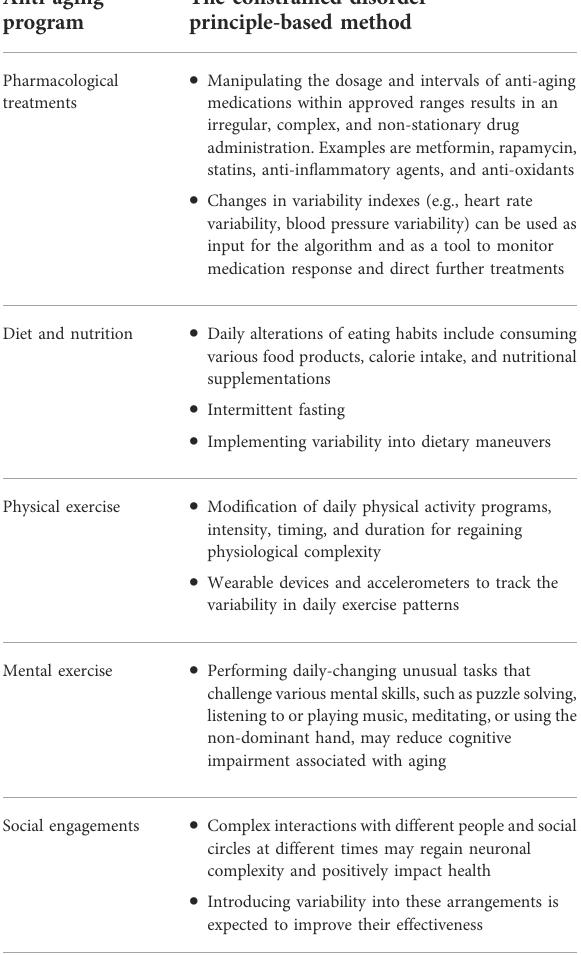
TABLE 1 Implementing the constrained disorder principle-based methods for improving anti-aging programs. Anti-aging The constrained disorder program principle-based method Pharmacological